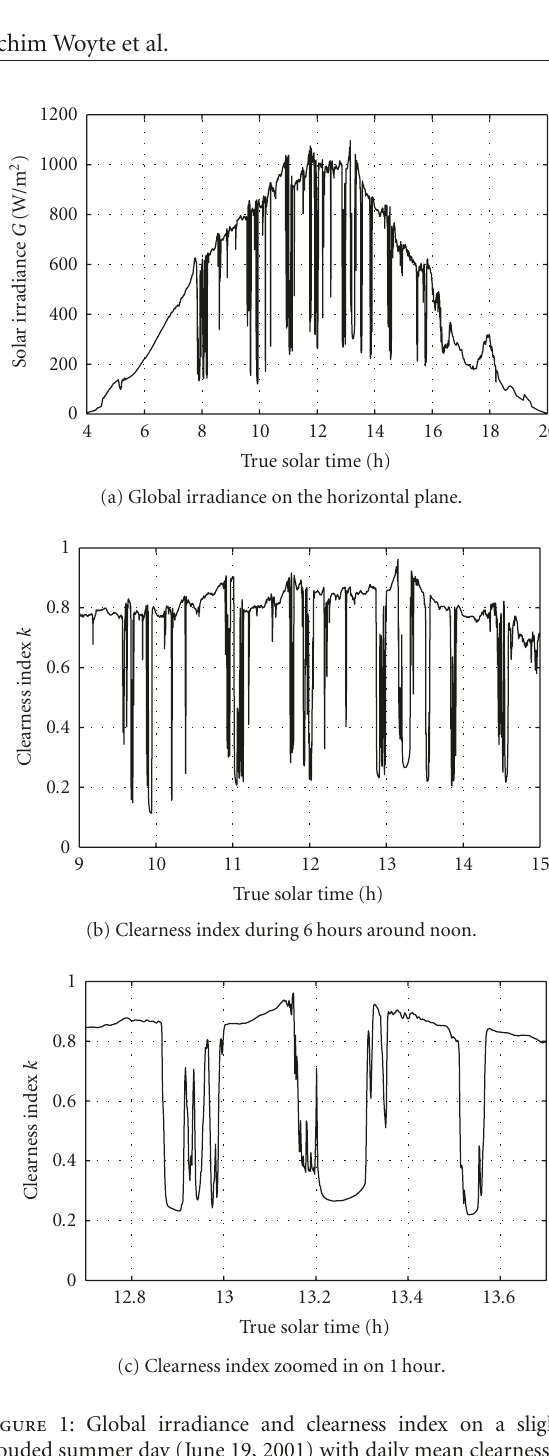
Figure 1: Global irradiance and clearness index on a slightly clouded summer day (June 19, 2001) with daily mean clearness in- dex k = 0 .